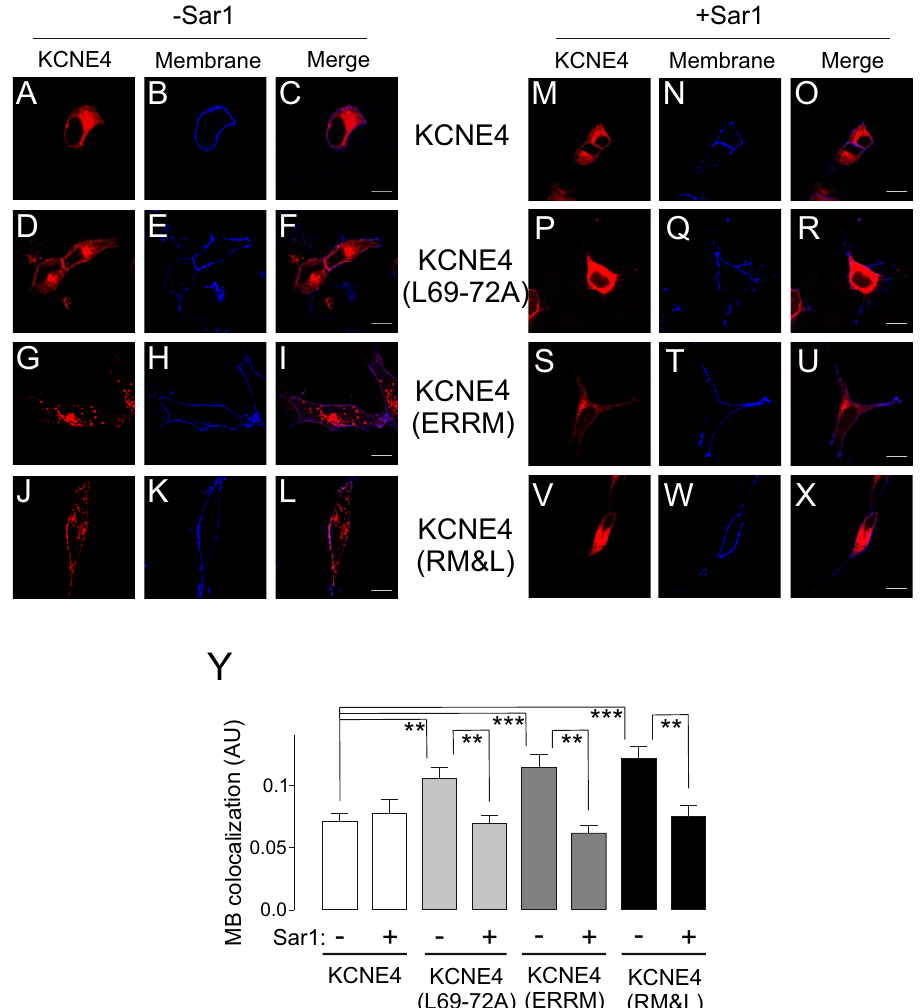
Figure 8. KCNE4 traffics to the plasma membrane via a COPII-dependent mechanism. HEK-293 cells were cotransfected with KCNE4WT and mutants (KCNE4(L69-72A), KCNE4(ERRM) and KCNE4(RM&L)) and the Akt-PH-pDsRed membrane marker in the absence (-Sar1, A-L) or the presence (+ Sar1, M-X) of HA-Sar1H79G. (A-C and M–O) KCNE4WT colocalization with the membrane marker. (D-F and P-R) KCNE4(L69-72A) colocalization with the membrane marker. (G-I and S-U) KCNE4(ERRM) colocalization with the membrane marker. (J-L and V-X) KCNE4(RM&L) membrane colocalization. Red panels, KCNE4. Blue panels, stained membrane. In the merged panels, purple indicates colocalization. Scale bars represent 10 µm. (Y) Quantification of membrane (MB) colocalization of KCNE4 in the absence ( −) or presence ( +) of HA-Sar1H79G (Sar1) using Mander’s coefficient. White columns, KCNE4 WT; light gray, KCNE4(L69-72A); dark gray, KCNE4(ERRM); black columns, KCNE4(RM&L). The values represent the mean of 20–30 cells. ** p < 0.01; *** p < 0.001 One-way ANOVA and post hoc Tukey’s